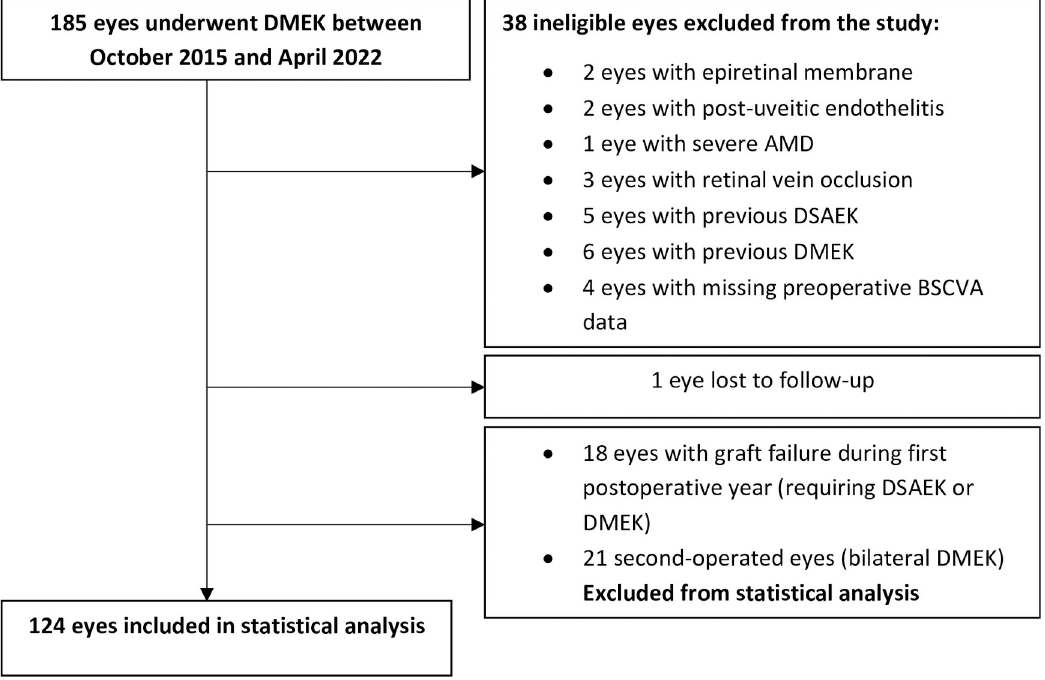
Fig 1. Flow chart depicting the disposition of the subjects during the study. AMD, age-related macular degeneration; DMEK, Descemet membrane endothelial keratoplasty; DSAEK, Descemet stripping automated endothelial keratoplasty.